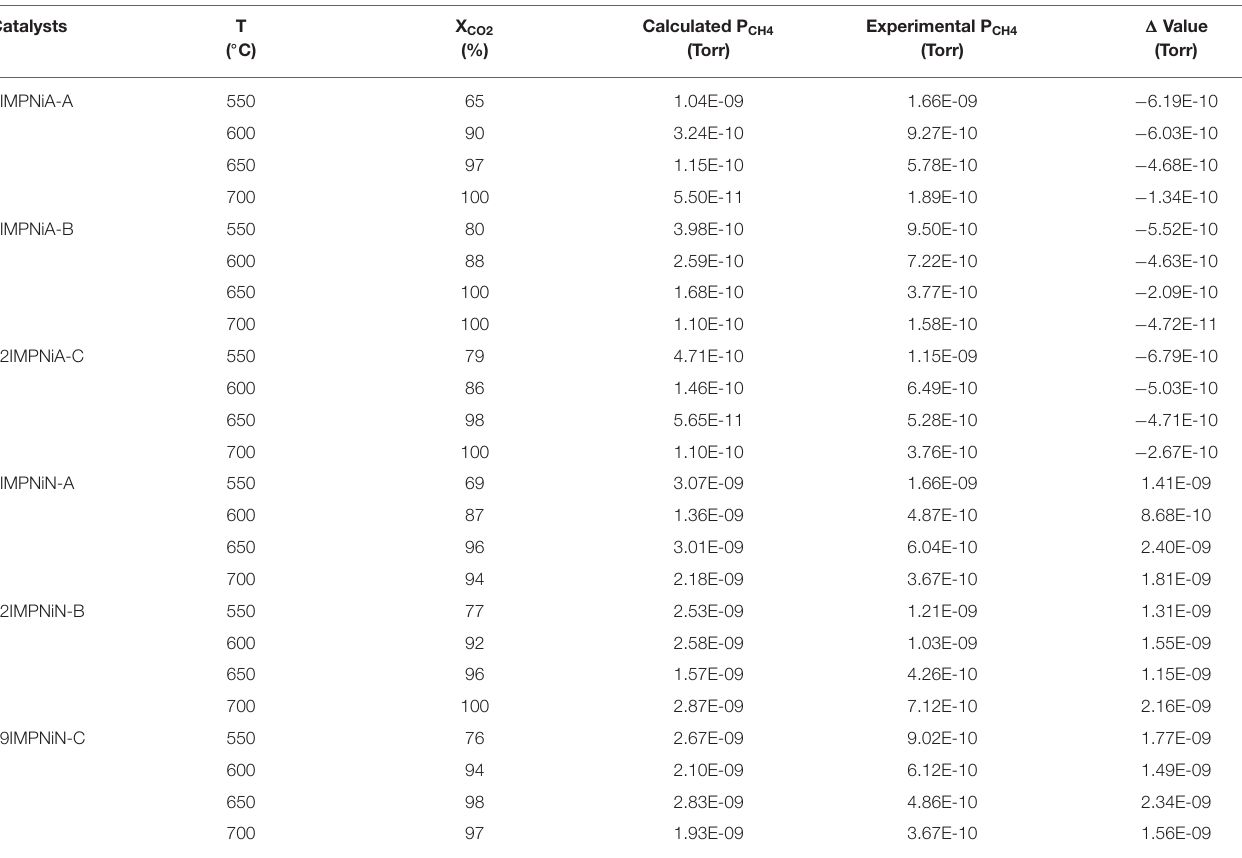
TABLE 3 | Calculated compared with measured methane pressure (leaving the microreactor) and CO 2 conversion for the monometallic Ni/SBA-15 catalyst samples at 550, 600, 650, and 700 ◦ C, respectively. Catalysts Calculated P CH4